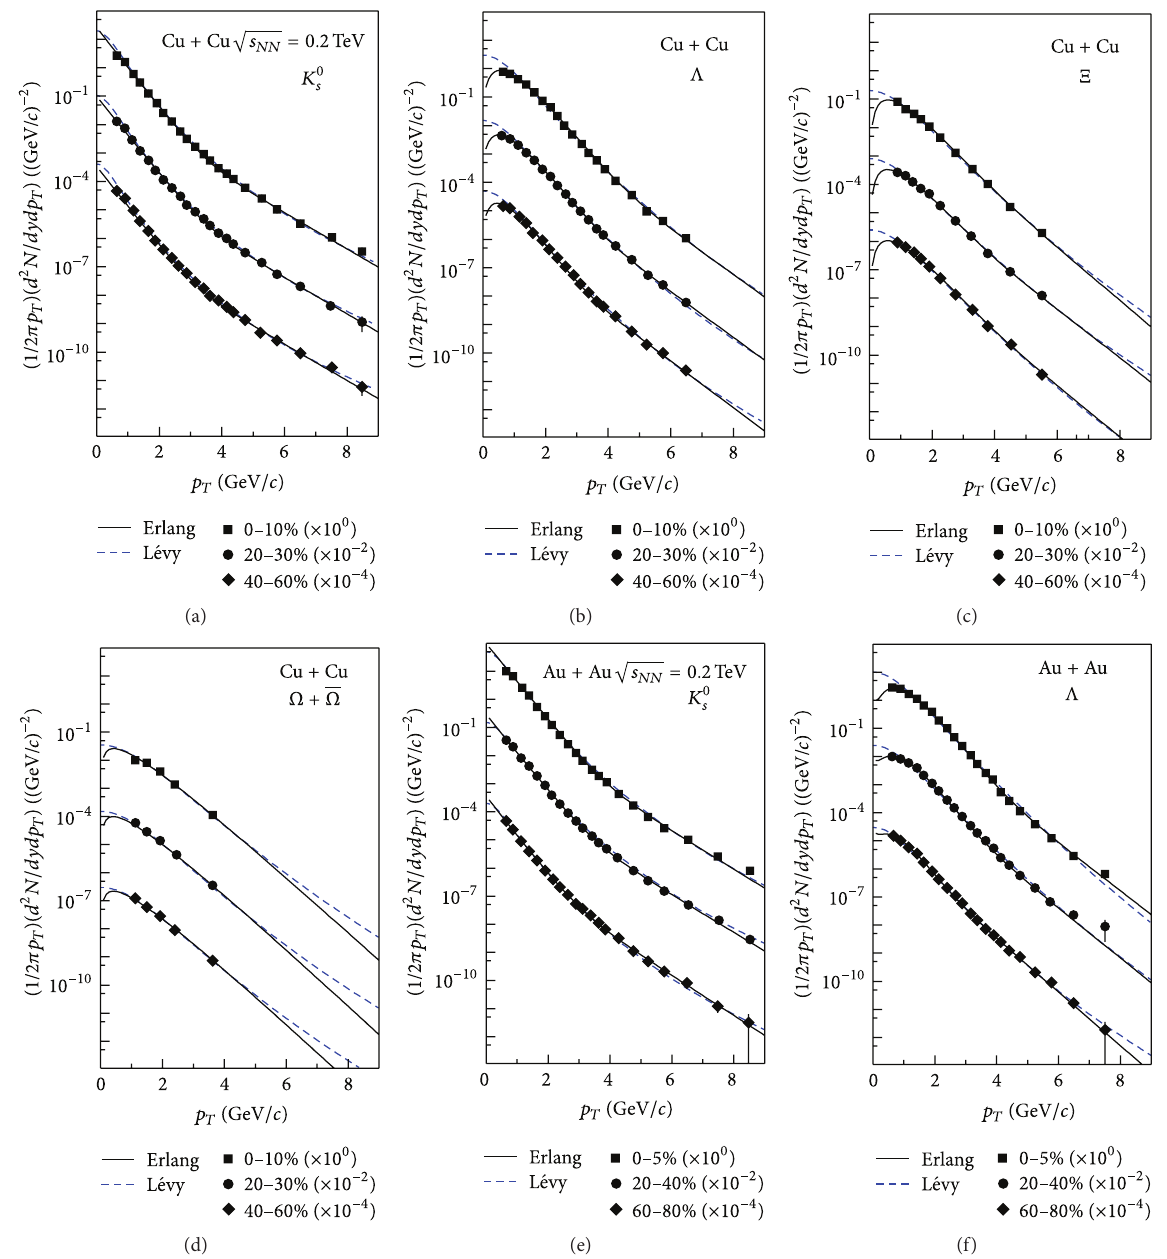
Figure 1: Transverse momentum spectrums of final-state particles produced in Cu-Cu and Au-Au collisions at √𝑠 𝑁𝑁 = 0.2 TeV. The symbols represent experimental data of the STAR Collaboration [11]. The solid and dashed curves represent results calculated by the multicomponent Erlang distribution and the L´evy distribution, respectively, (a), (b), (c), (d), (e), and (f) correspond to different final-state particles and